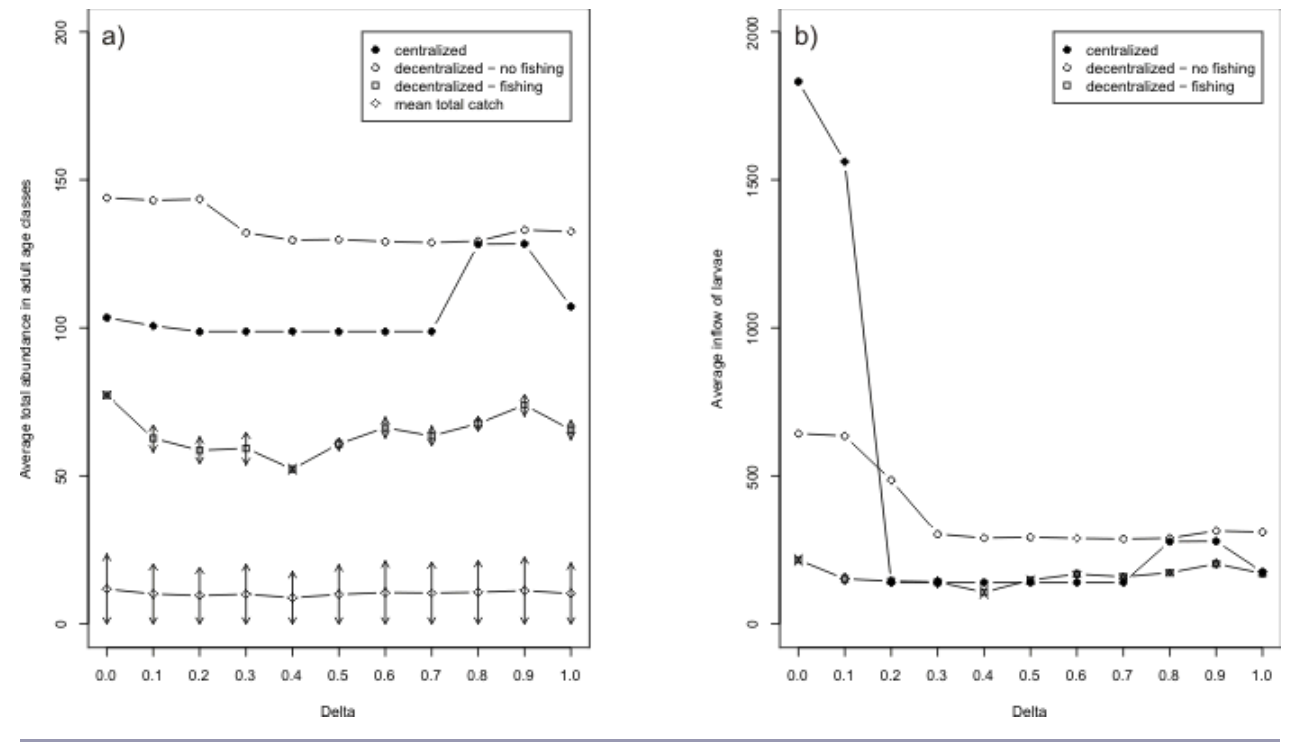
Fig. 9. . A) Total mean abundance in adult age classes of the fish population with different deltas for the centralized, decentralized without fishing, and decentralized with fishing models. Mean catch for the decentralized model with fishing. B) Mean inflow of larvae into the fish population with different delta for the centralized, decentralized without fishing, and decentralized with fishing models. Parameter values are the same as in Fig.